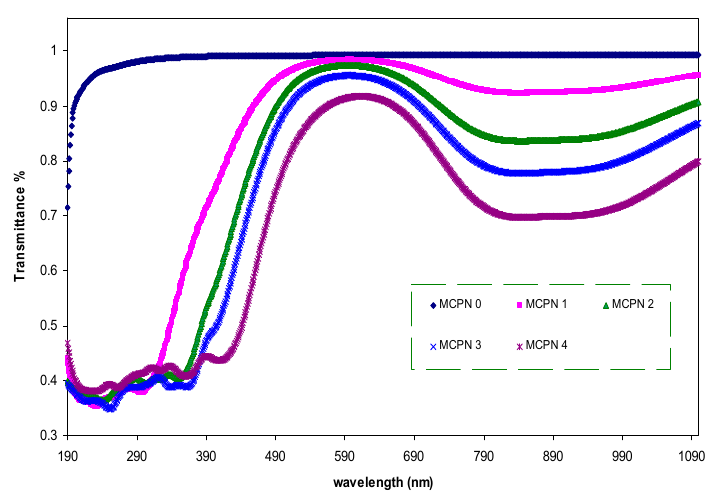
Figure 1. The transmittance spectra of pure MC (methyl cellulose) and doped MC samples.